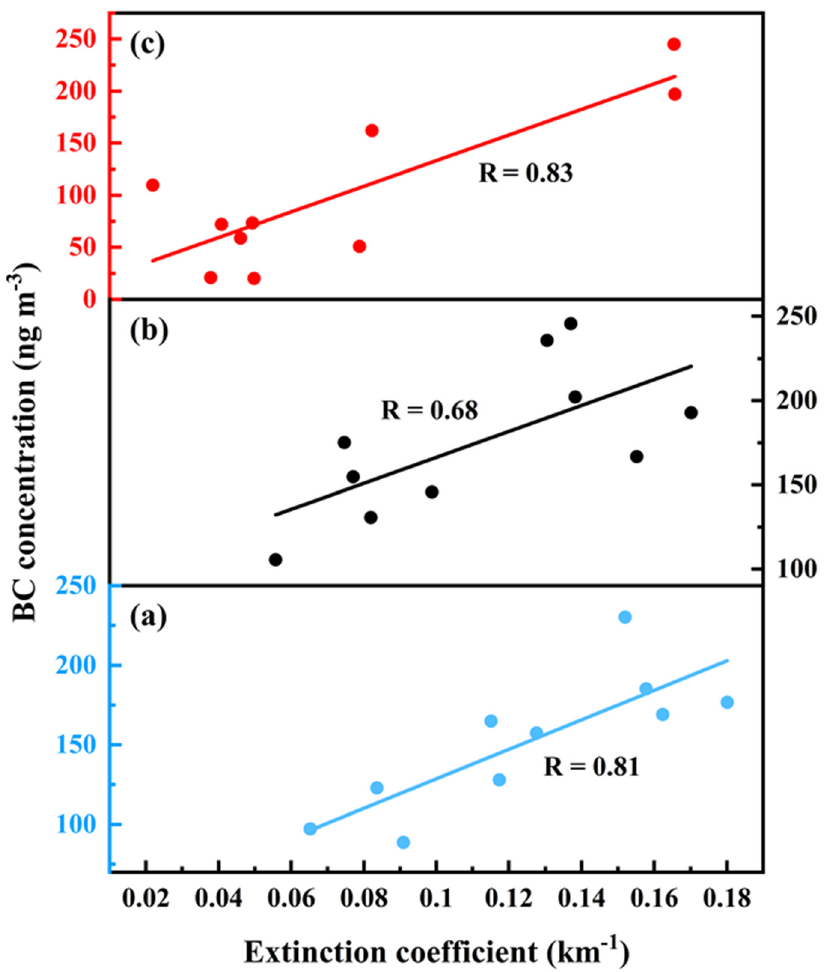
Figure 8. The linear correlation between BC concentration and extinction coefficient at three different layers, with correlation coefficients (R) shown in the figure. ( a ) 250 m, ( b ) 350 m, and ( c ) 550 m. 3.3. Contribution of Anthropogenic PM 2.5 to Non-Local Aerosols over the